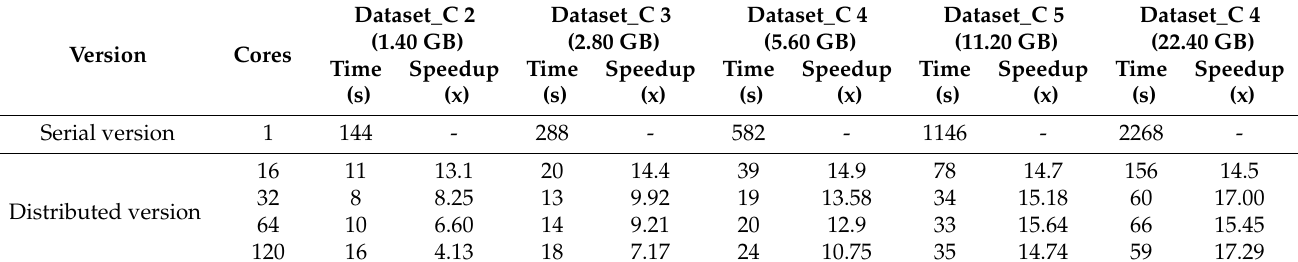
Table 3. Execution time and speedup of the serial and distributed parallel versions of SCLS with dataset_C 2-6.